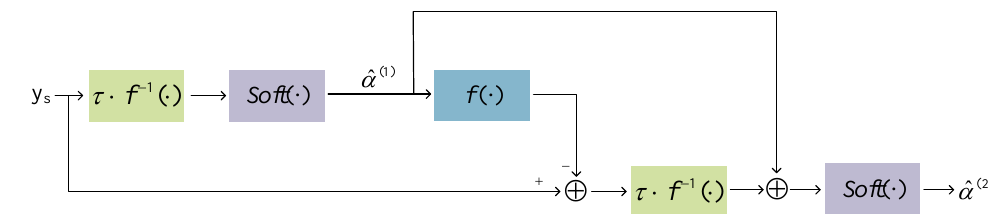
Figure 4. The feed-forward neural network constructed by unfolding T = 2 iterations of RMIST-Net.